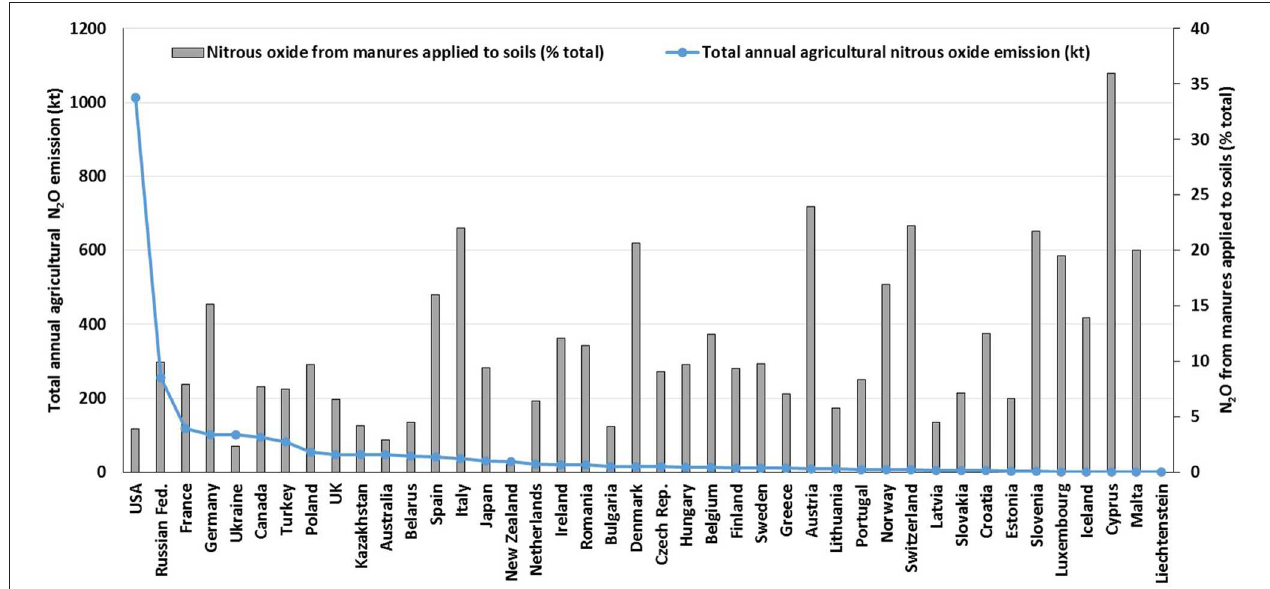
FIGURE 1 | Annual (2016) agricultural N 2 O emissions and direct N 2 O emissions from manure applied to soils, expressed as a percentage of the total agricultural N 2 O emission, from different nations (source: UNFCCC,